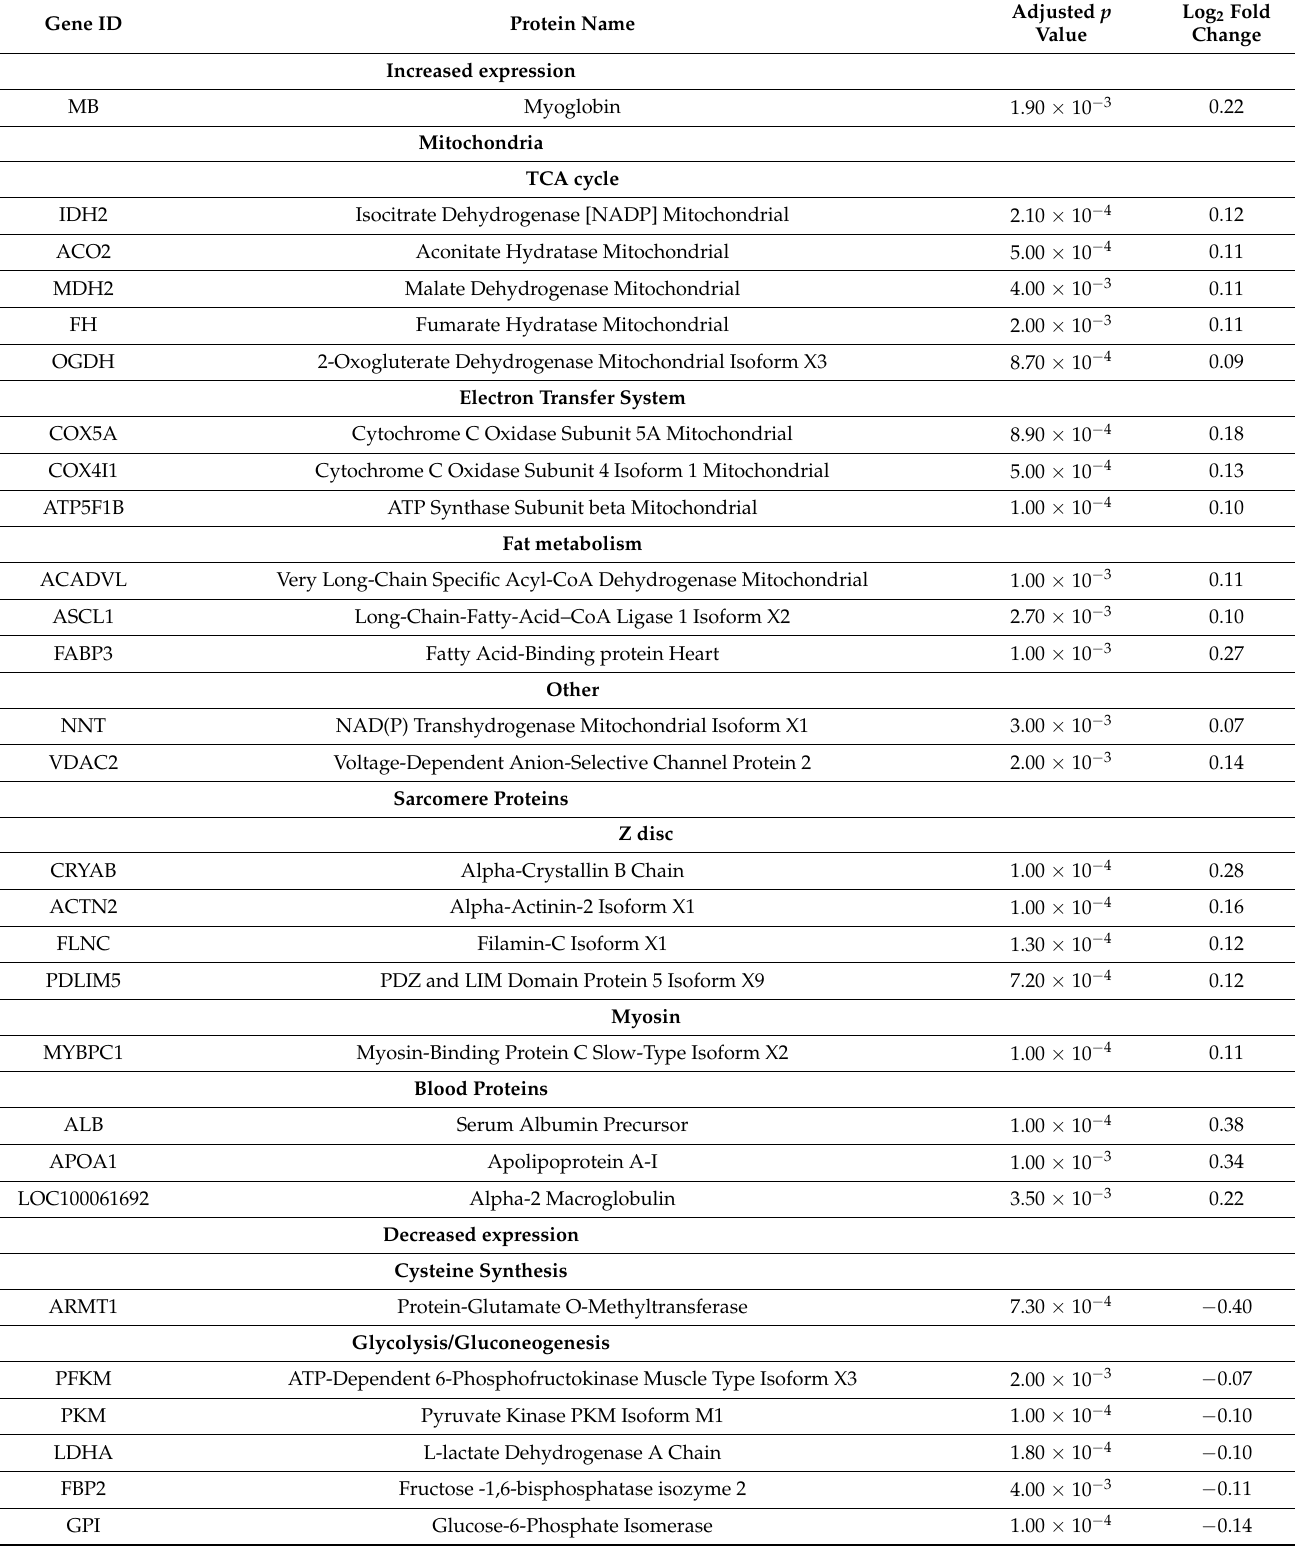
Table 4. The gene identification for a protein, protein name, log 2 fold change, and p value adjusted for multiple test corrections in five geldings supplemented with NACQ compared to